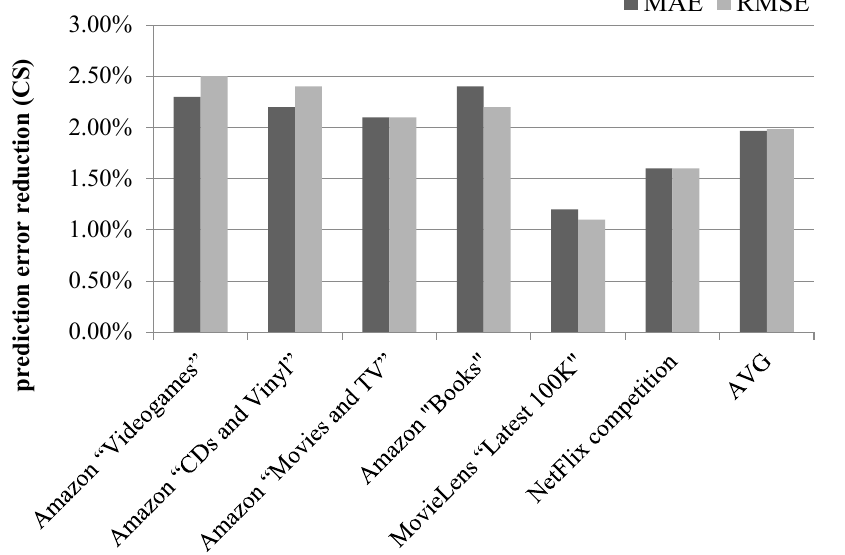
Figure 3. MAE and RMSE reduction achieved by the proposed algorithm, when using the CS user similarity metric. The proposed algorithm achieves an average prediction MAE reduction of 2% and an average prediction RMSE reduction of 2%, as well, when using the CS user similarity metric. At the individual dataset level, the performance edge of the proposed algorithm against the plain CF algorithm, ranges from 1.2% and 1.1% (for the MovieLens 100K da- taset) to 2.3% and 2.5% (for the Amazon “Videogames” dataset), for the MAE and the RMSE metrics, respectively. 4.3. Combining the Proposed Algorithm with a Second Algorithm Targeting Rating Prediction Accuracy Improvement As stated in the introduction, the proposed algorithm can be easily fused with other CF approaches, aiming to enhance rating prediction accuracy. The rationale behind the evaluation of the combination of the proposed algorithm with another algorithm is that, currently, many recommender systems have been imple- mented and use diverse algorithms that aim to achieve increased accuracy. A recom- mender system administrator may wonder whether the algorithm employed in their sys- tem needs to be replaced by the proposed one, and which would be the resulting benefits, or whether the proposed algorithm may be combined with the one already employed and if so, what would the benefits be. As a result, the following experiment offers useful in- sight regarding the additional accuracy gains that may be reaped for existing recom- mender systems, if the proposed algorithm is incorporated to complement any existing algorithm(s). Towards this direction, the third experiment aims at assessing the rating prediction accuracy improvement when combining the proposed algorithm with another CF rating prediction accuracy approach. In particular, we report on our experiments where the pro- posed algorithm is combined with the CF EPC algorithm [54]. The CF EPC algorithm is a state- of-the-art algorithm (published towards the end of 2020), also targeting at improving the CF rating prediction accuracy, and not needing any additional information on the items or the users (e.g., user social relationships or item categories). Hence, it can be also applied in all CF datasets. Figure 4 illustrates the improvement in the MAE achieved by the inclu- sion/combination of the presented algorithm to the CF EPC algorithm, when using the PCC